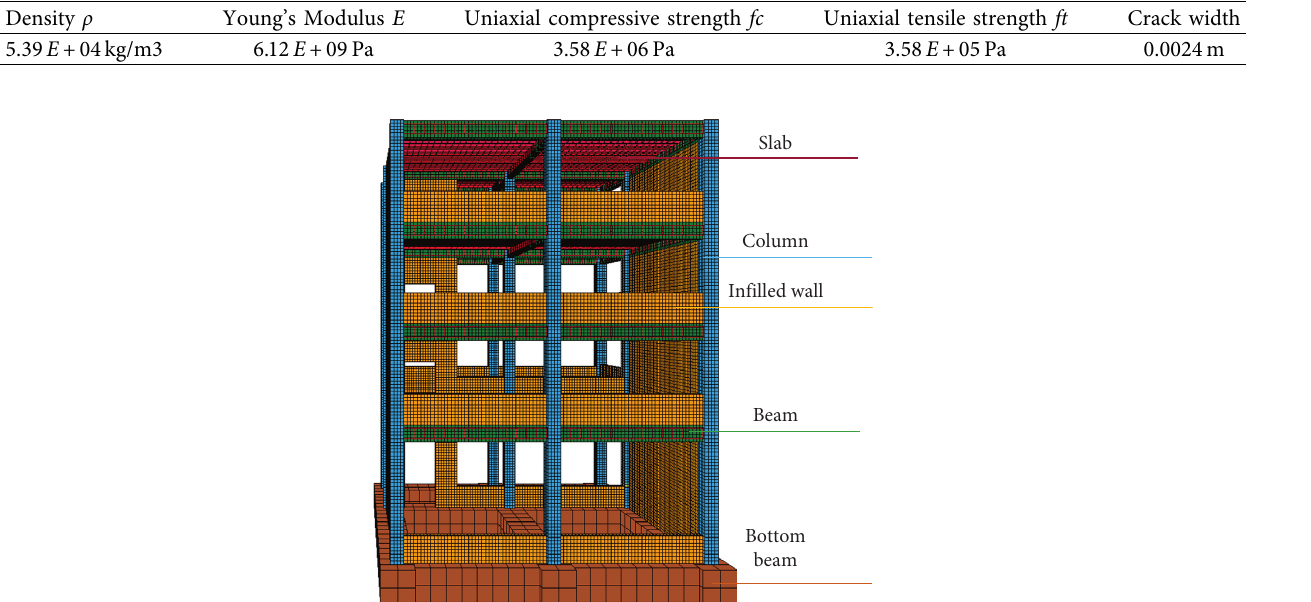
Table 3: Winfrith-Concrete model parameters (unit: N, m, Pa, s).